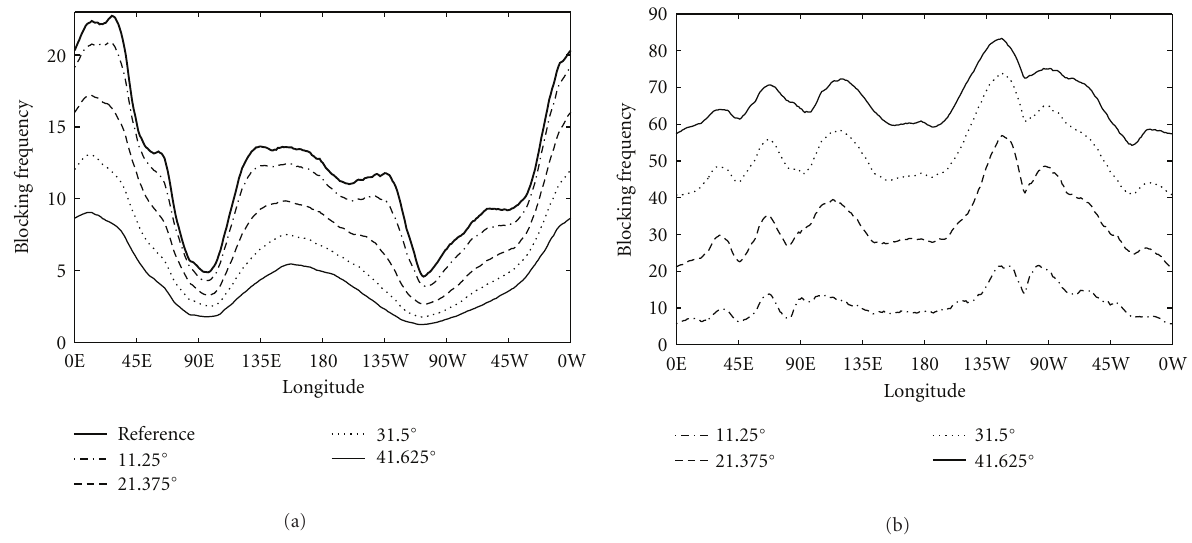
Figure 4: Extent filter: Northern Hemisphere blocking frequency (a) reference setup and varying filter thresholds, (b) relative changes.